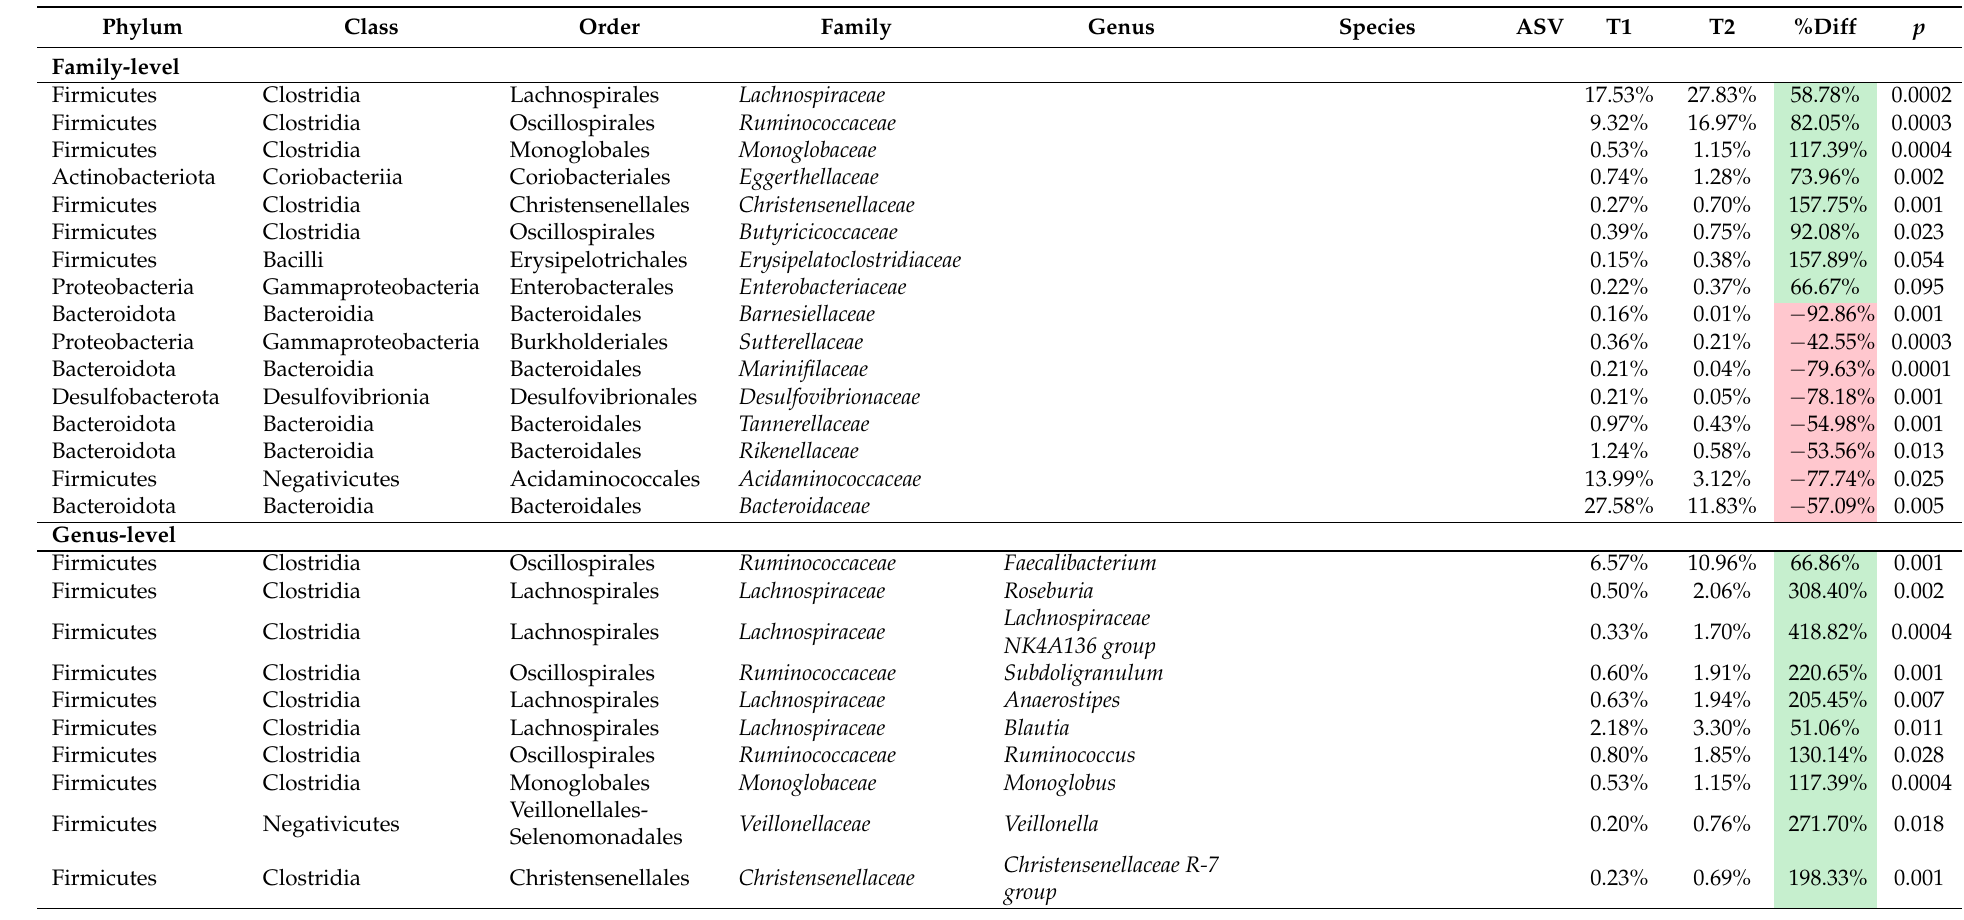
Table 3. Microbiome shifts within individual. Pairwise Wilcoxon statistics for MT cohort (N = 22). The 20 most abundant taxa (23 families, 23 genera, 27 species, and 24 ASVs) at each level were compared. Median relative abundance (as a percentage of the microbiome composition) and percent change of the families, genera, species, and ASVs that differed significantly within-person across the two time points are presented for the taxonomic differences with a p value < 0.1. Taxa that increased or decreased between timepoints are indicated in green and red, respectively. Statistics for all pairwise tests are provided in Supplementary Table S1. Taxonomic assignments are based on the Silva 138 database. The sequences for the ASVs that were tested are provided in Supplementary Material (Supplementary Table S2). ASV, amplicon sequence